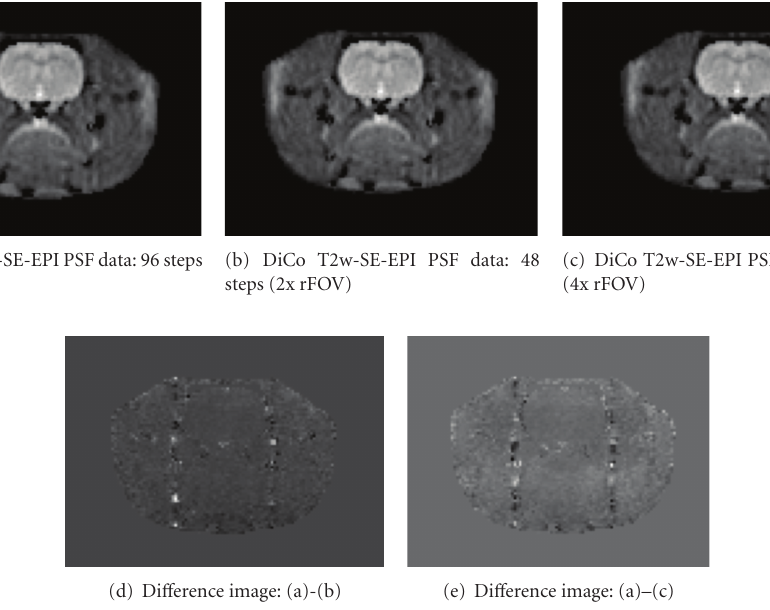
Figure 6: Comparison of results from EPI distortion correction using accelerated PSF data acquisition with reduced FOV. Image (a) shows a T2w SE-EPI after distortion correction using a PSM from full PSF data acquisition. For comparison, (b) and (c) show results from the correction process using PSF data with 2x and 4x acceleration. No di ff erence in image quality can be seen. The di ff erence images between images (a)-(b) and (a)–(c) are given in the lower row as (d) and (e),